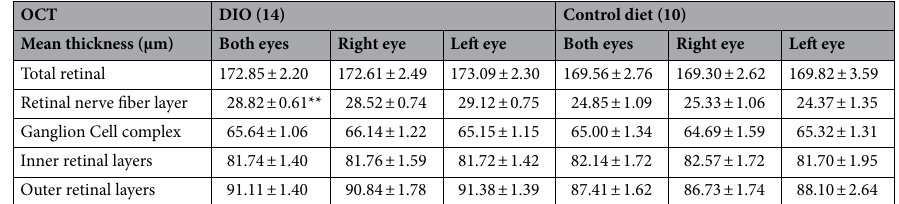
Table 1. Retinal layer thickness. Table summarizing the thickness of the retinal layers at OCT prior to implantation surgery. N in parentheses. Data are presented as mean±SEM. **=P<0.01.